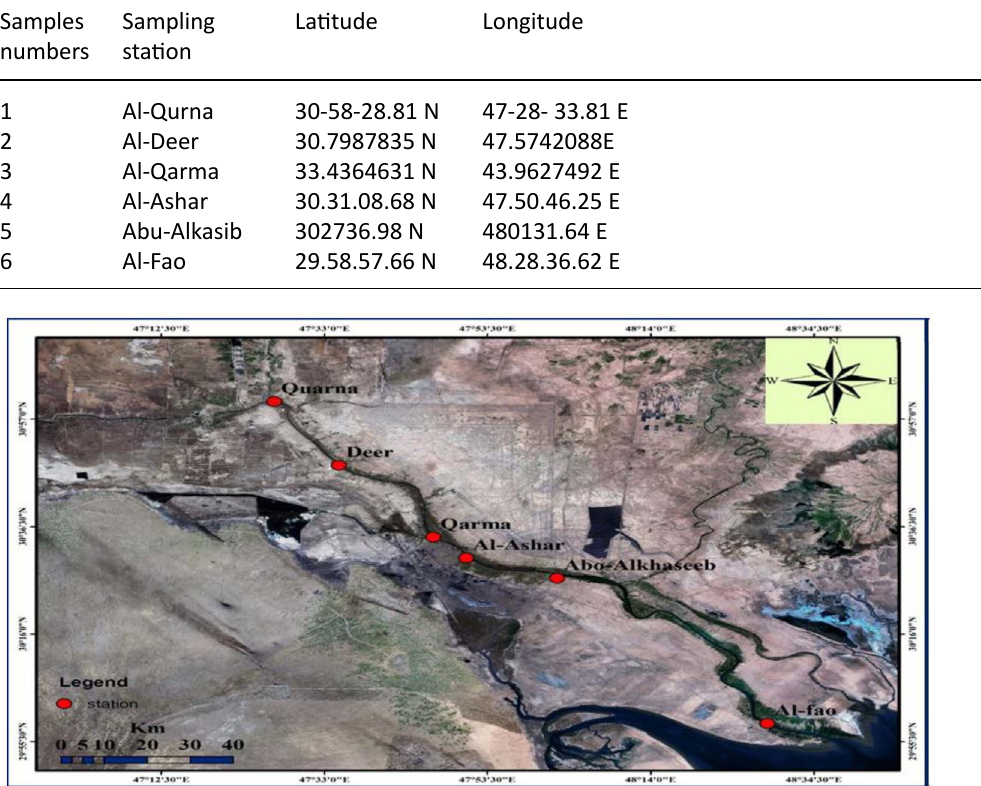
Fig. 1. The location of studied area Sediments sampling and